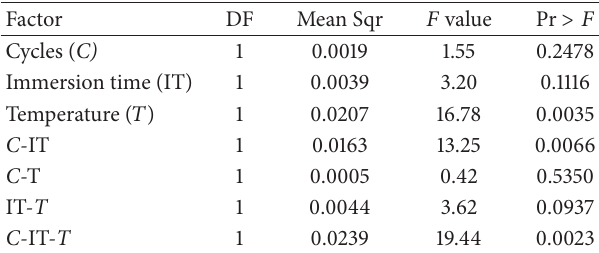
Table 3: Analysis of variance (ANOVA) for superoxide radical generation in photoactivity assays (TiO endosulfan